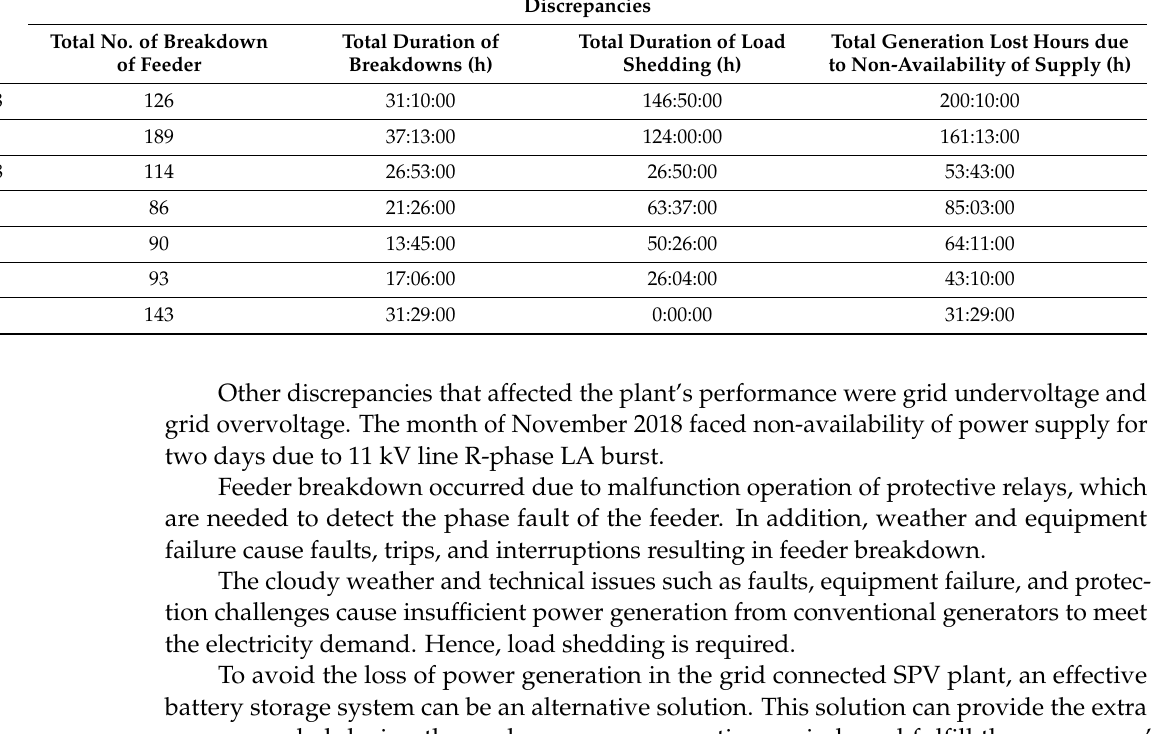
Table 4. Breakdown, load shedding, and a generation lost hours of seven months.